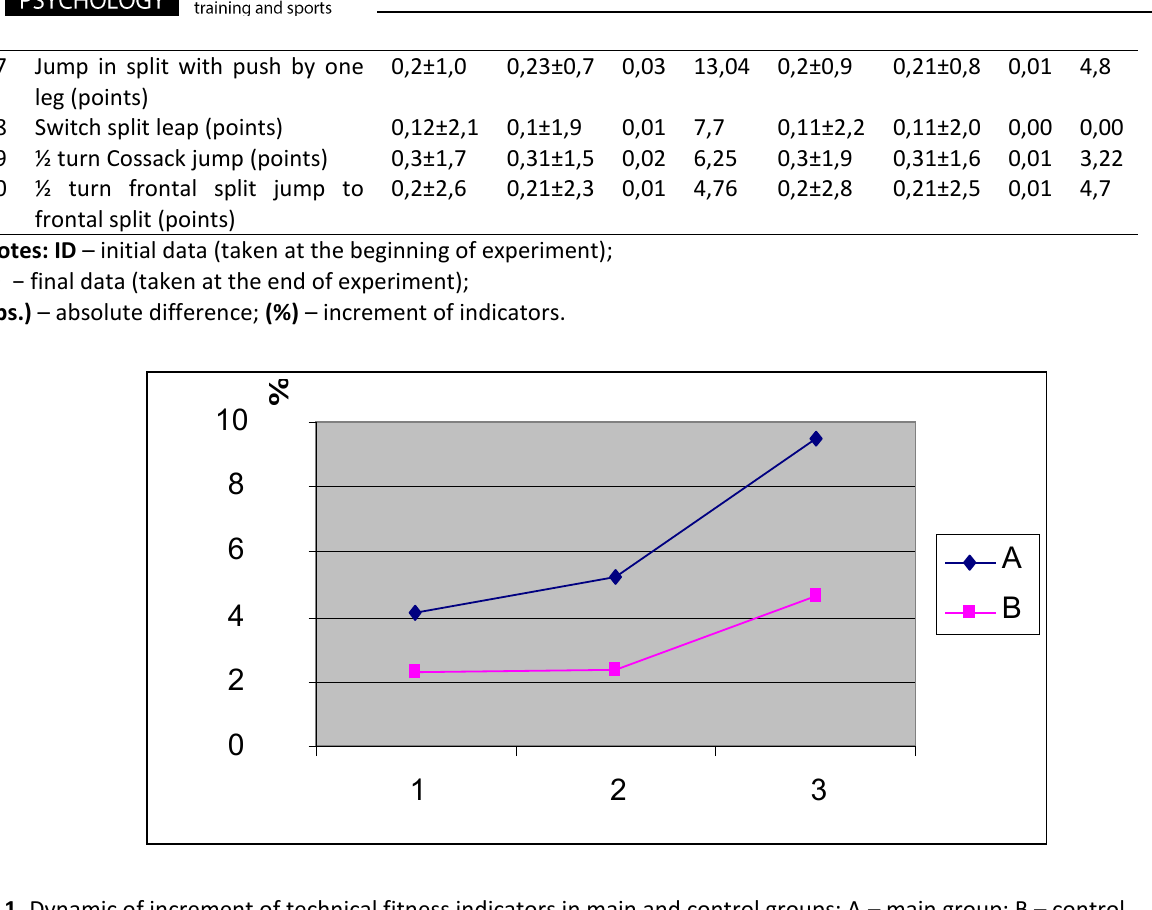
Fig.1. Dynamic of increment of technical fitness indicators in main and control groups: A – main group; B – control group; % – increment in